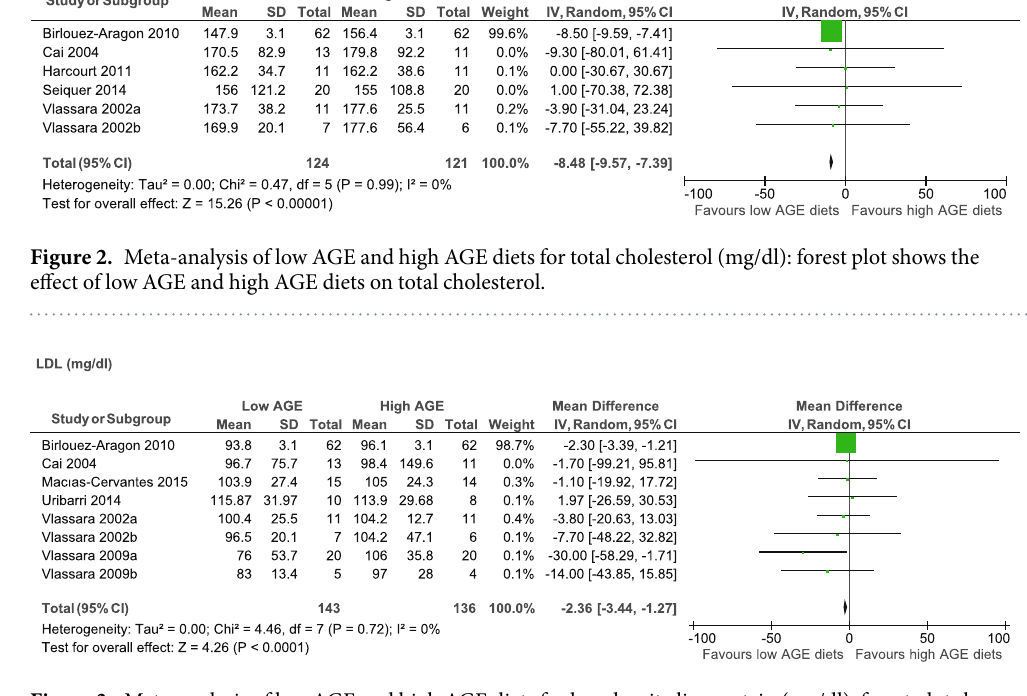
Figure 3. Meta-analysis of low AGE and high AGE diets for low density lipoprotein (mg/dl): forest plot shows the effect of low AGE and high AGE diets on low density